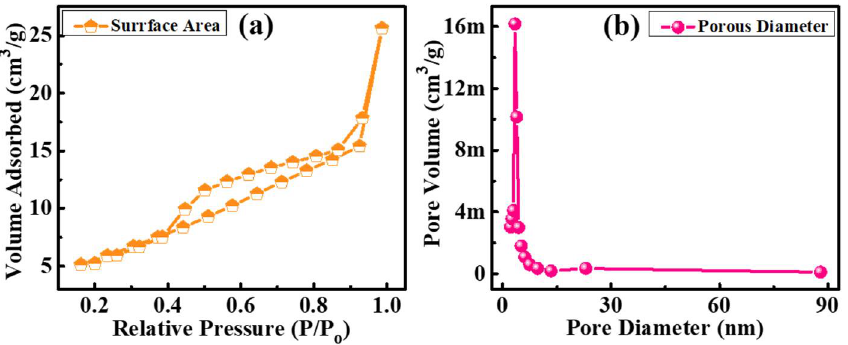
Figure 8. ( a ) Barrett–Joyner–Halenda (BJH) adsorption-desorption isotherm and ( b ) pore size distribution of β-SnWO 4